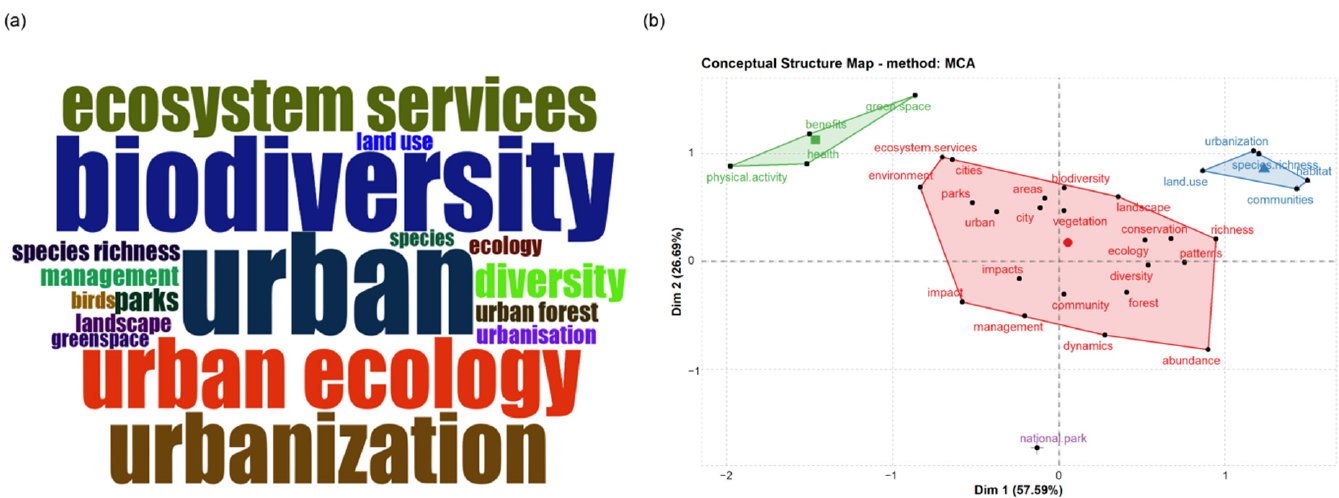
Figure 5. Keywords analysis. ( a ) The word cloud which has 27 keywords with a frequency of over 50 ( b ) According to the keywords, four color clusters of red, green, blue, and purple are formed, and different clusters show different keyword